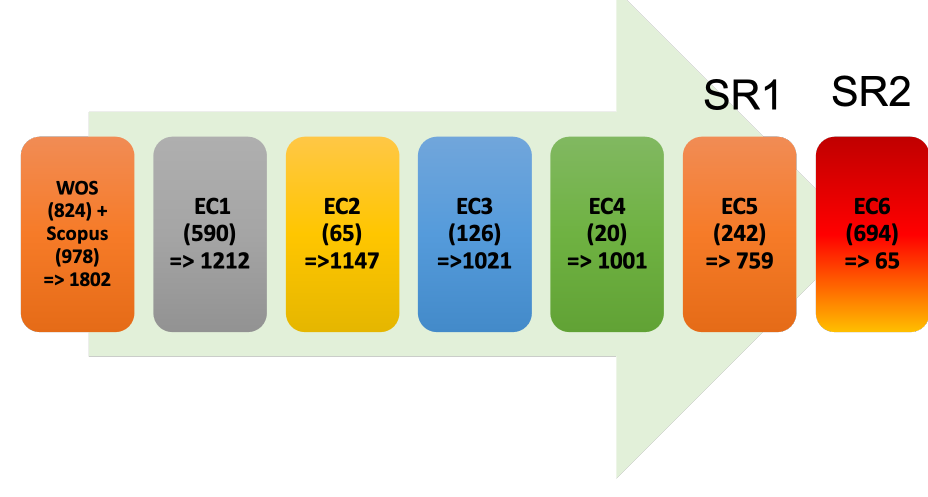
Figure 2. The systematic review